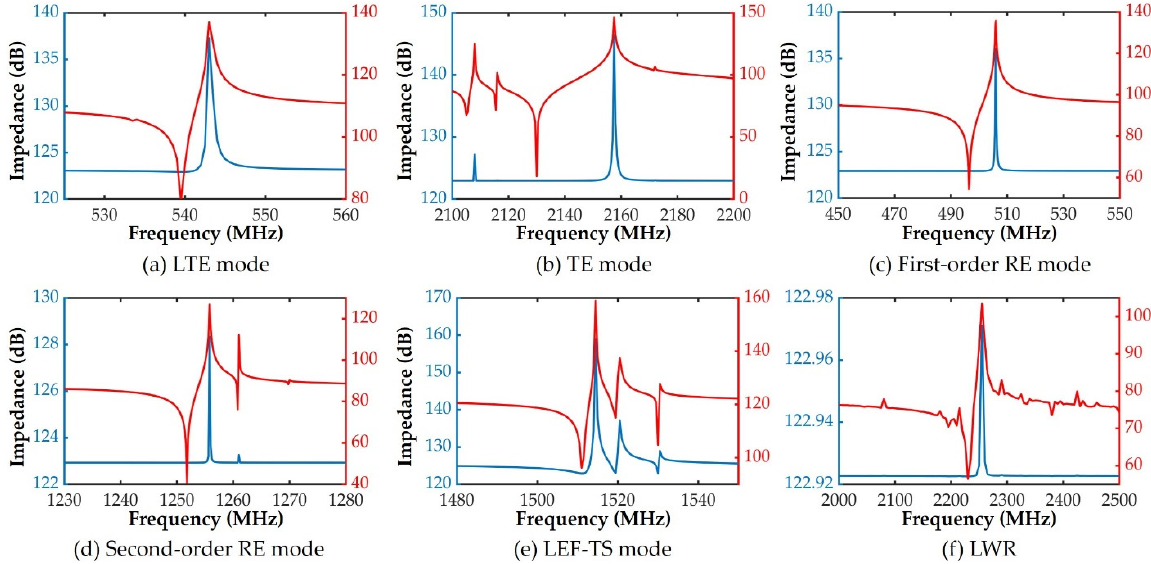
Figure 4. The impedance spectra of resonators before (blue curves) and after (red curves) de-embedding the pad: ( a ) length thickness extension, ( b ) thickness extension, ( c ) first-order radial extension, ( d ) second-order radial extension, ( e ) lateral electric field excited thickness shear mode resonators and ( f ) lamb wave resonator.